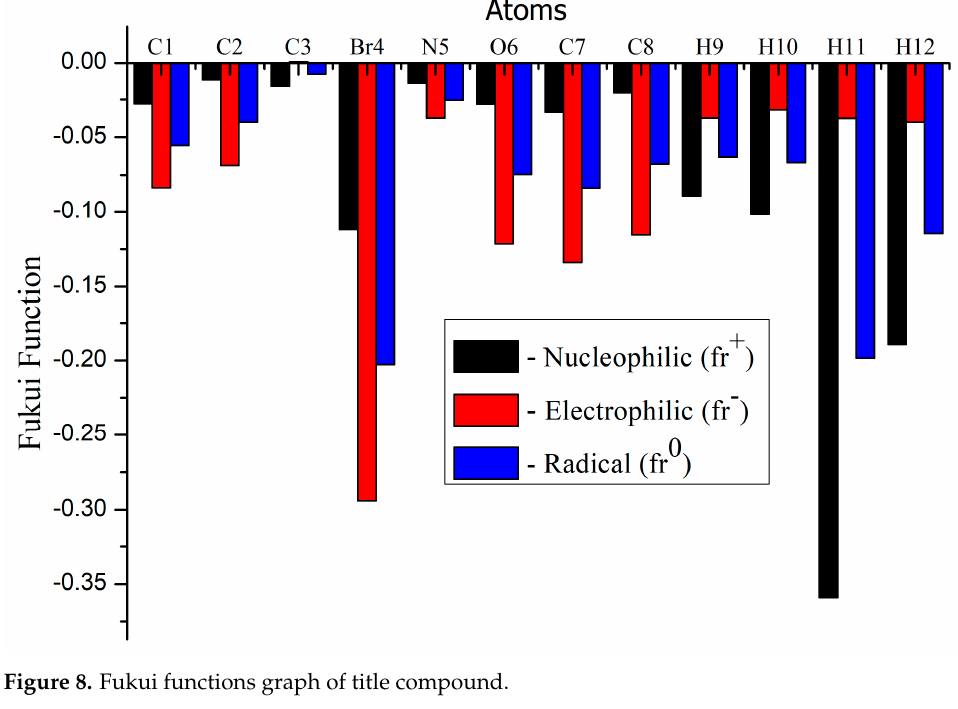
Figure 8. Fukui functions graph of title compound. Table 6. Natural population distribution, Fukui functions and dual descriptor of the title compound.